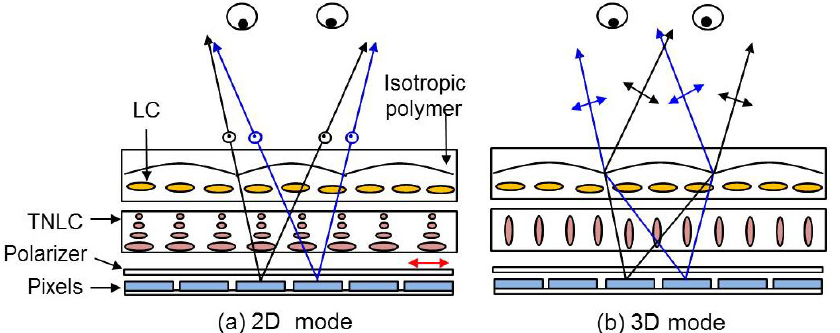
Figure 6. Operation principle of a switchable 2D/3D display with a TN broadband polarization rotator (middle) and a polymeric microlens array (top): ( a ) voltage-off and ( b )